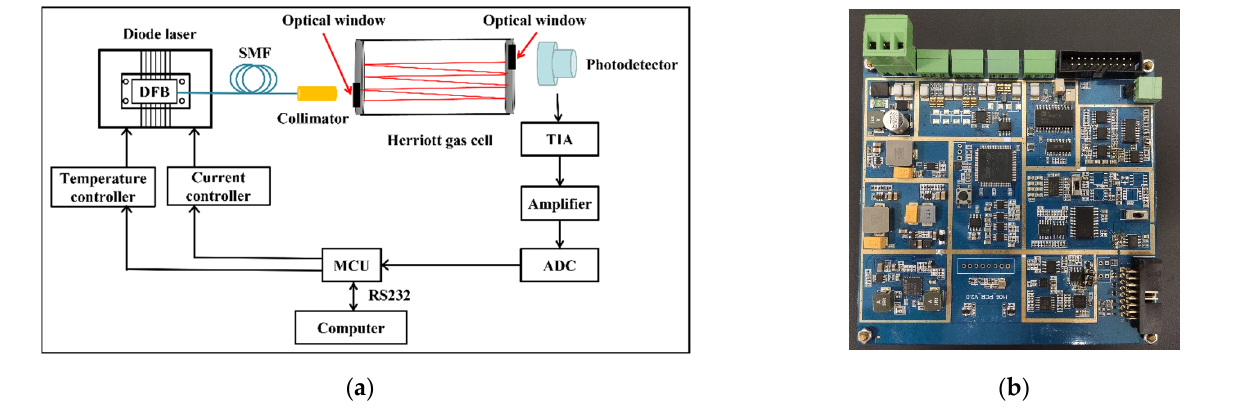
Figure 1. Experimental setup for the proposed humidity sensor. ( a ) Schematic diagram of the experimental setup; ( b ) picture of the homemade circuit.